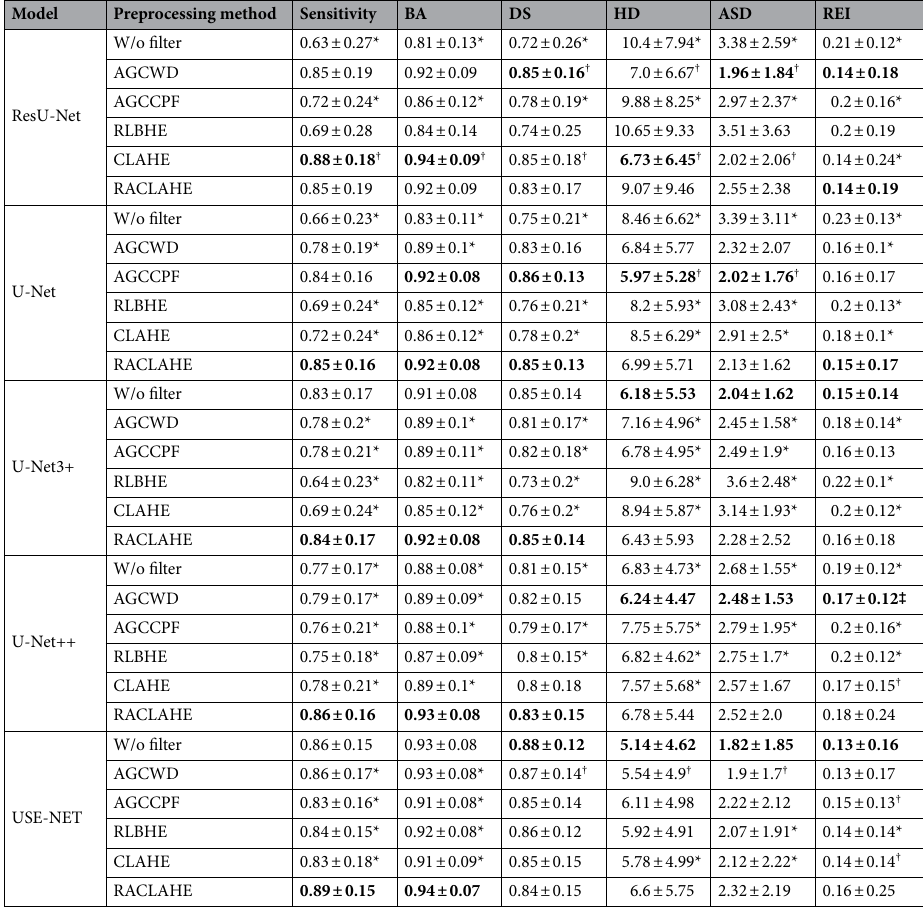
Table 1. Whole gland (WG) segmentation performance. BA balanced accuracy, DS dice score, HD Hausdorff distance, ASD average surface distance, REI Rand error index, AGCWD adaptive gamma correction with weighting distribution, AGCCPF adaptive gamma correction with color preserving framework, RLBHE range limited Bi-histogram equalization, CLAHE contrast limited adaptive histogram equalization, RACLAHE region adaptive contrast limited adaptive histogram equalization. *RACLAHE performs significantly better than the corresponding method (p-value ≤ 0.05; Wilcoxon rank-sum test). † This method is significantly better than RACLAHE (p-value ≤ 0.05; Wilcoxon rank-sum test). The best performance scores for each model are shown in